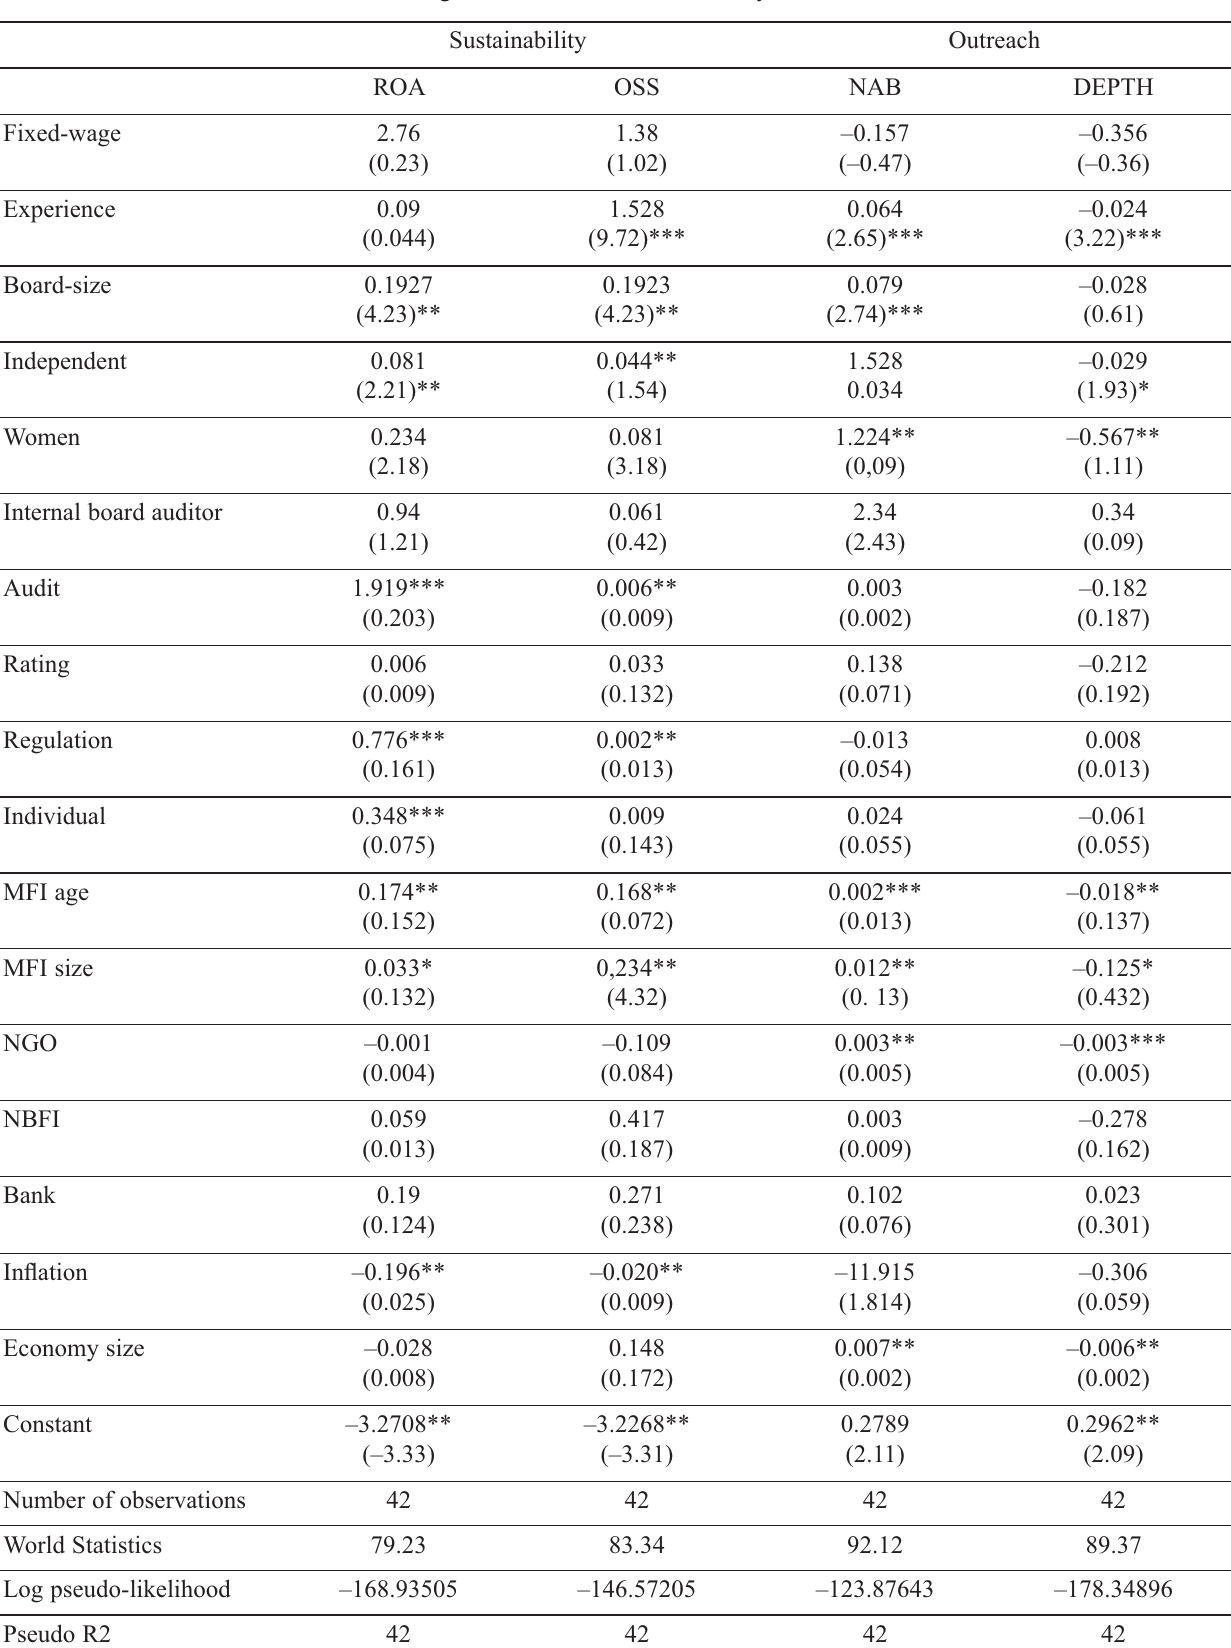
Table 4. Regression Results of sustainability and